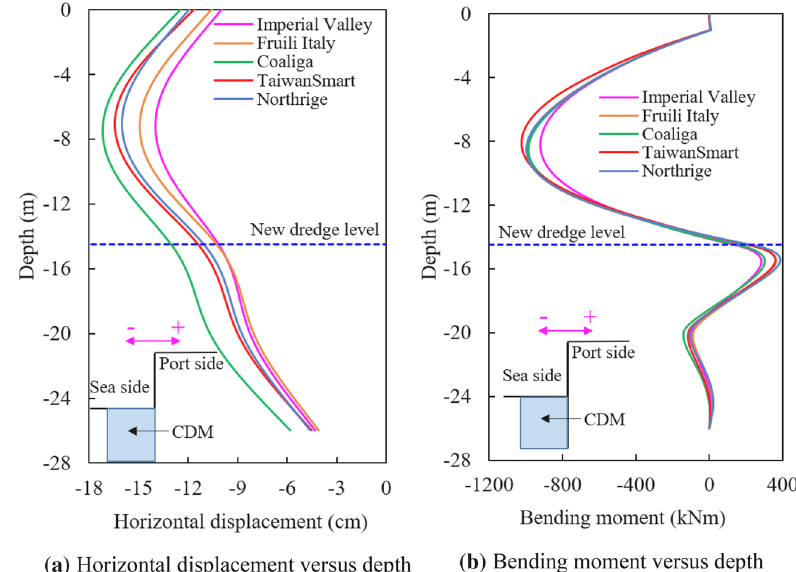
Fig. 10 Horizontal displacement and bending moment of the sheet pile at the end of the different earthquake